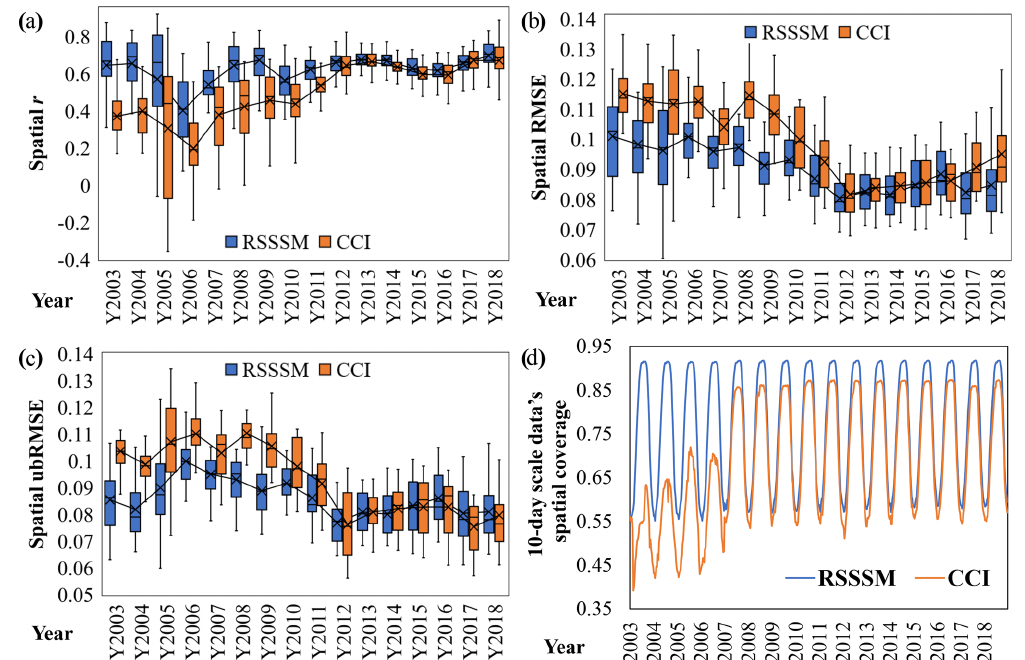
Figure 13. Changes in the data quality and data spatial coverages of RSSSM and CCI soil moisture with year. The interannual changes in (a) spatial-correlation coefficients ( r ), (b) spatial RMSE, (c) spatial ubRMSE values, and (d) the spatial coverages of 10d period data for RSSSM and CCI.